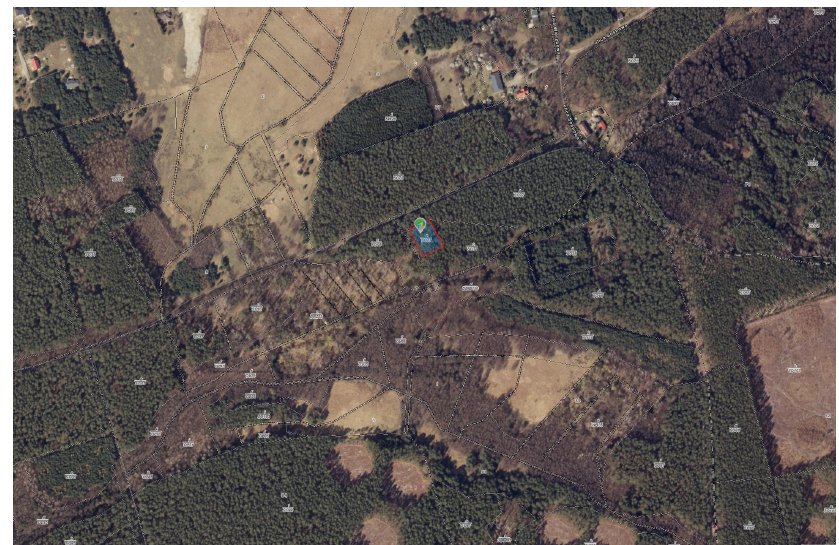
Figure A1. Location of the experimental stand in Poland in 2019.